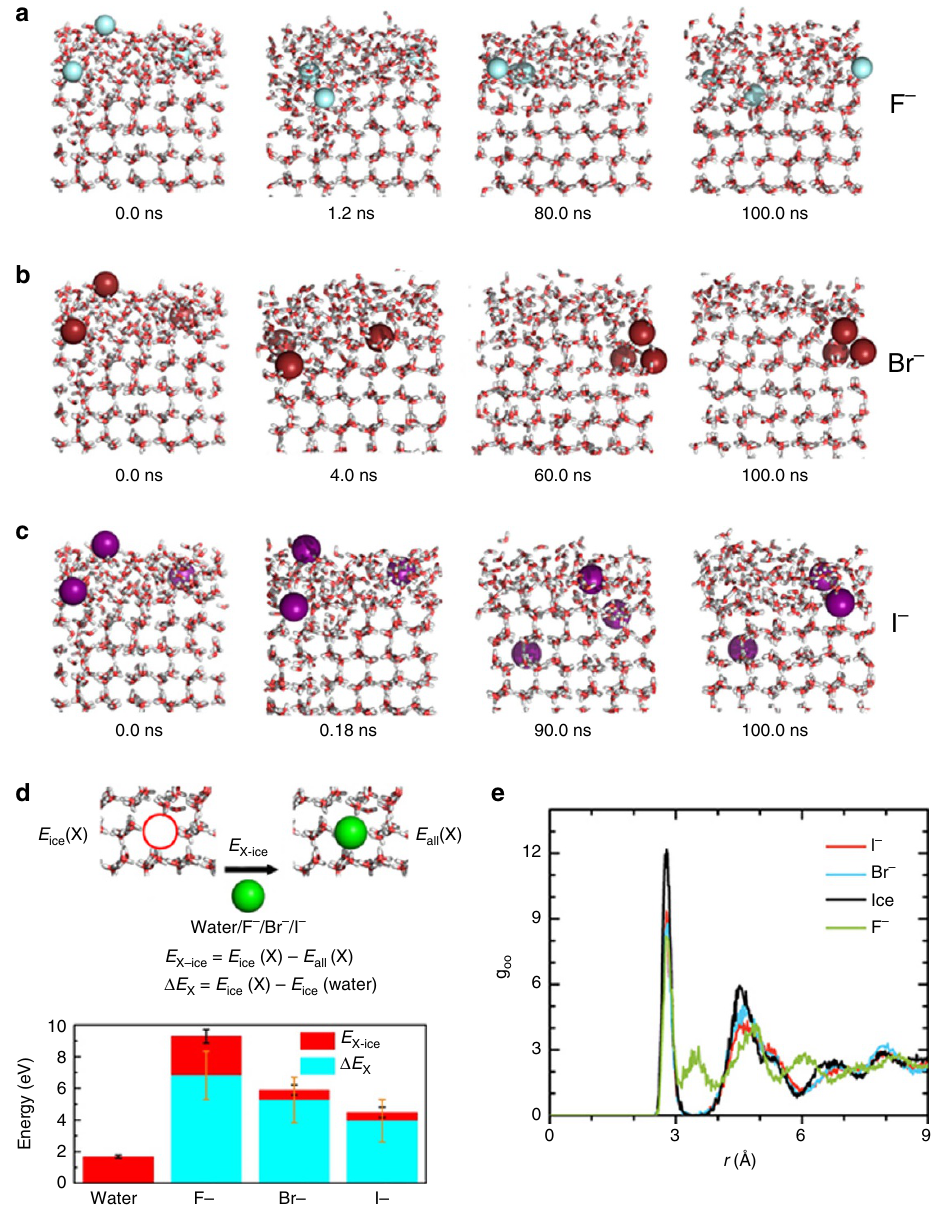
Figure 4 | Molecular dynamics simulations. Snapshots of the MD simulations for illustrating the effect of ( a ) F (cid:2) , ( b ) Br (cid:2) or ( c ) I (cid:2) ions on ice formation at (cid:2) 13 (cid:2) C. ( d ) Results of test MD simulation (see Methods) for computing average interaction energy ( E X-ice ) of a water molecule or an ion with the surrounding water molecules in the bulk ice are depicted by the height of red bars (results being averaged over 50 configurations in the last 100ps of the 1ns test MD simulations). Here, E all (X) denotes the total potential energy of the system after the replacement of two tagged water molecules with X (X ¼ water, F (cid:2) , Br (cid:2) or I (cid:2) ) and Na þ . The potential energy increase ( D E X ) for the pure ice crystal due to the presence of the embedded ions is marked by the height of cyan bars. The root-mean-square error bars (black and yellow) are calculated based on the data of 50 configures in the last 100ps. ( e ) Computed radial distribution functions of O atoms in pure ice and O atoms surrounding the halide